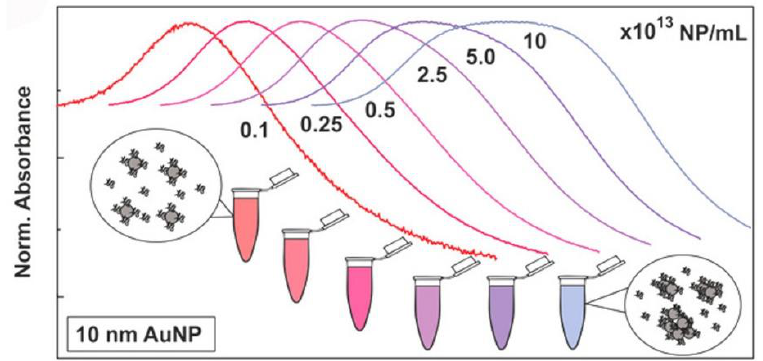
Figure 4. Normalized UV−vis spectra of AuNPs in cCCM at different concentrations. The changes in the LSPR band indicate that AuNPs aggregated in the cCCM when exposed to the medium at high concentration while their stability was not compromised at low concentration. Reprinted with permission from [10]. Copyright (2017) American Chemical Society.